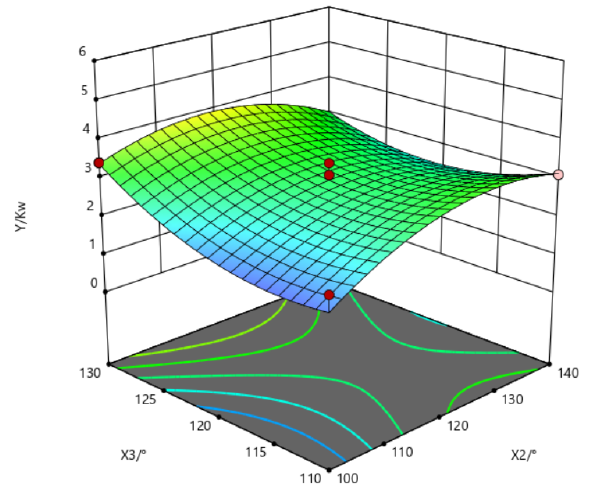
Figure 11. X 2 X 3 interaction response surface.